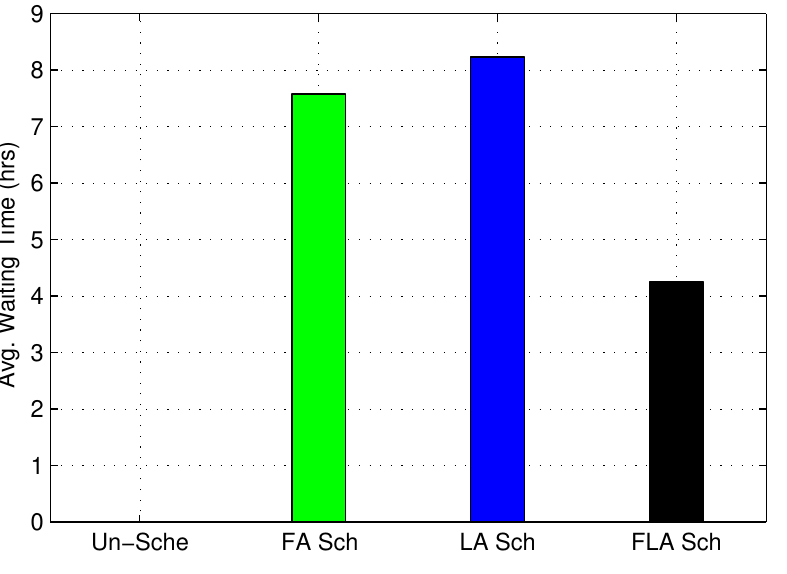
Figure 8. Average Waiting